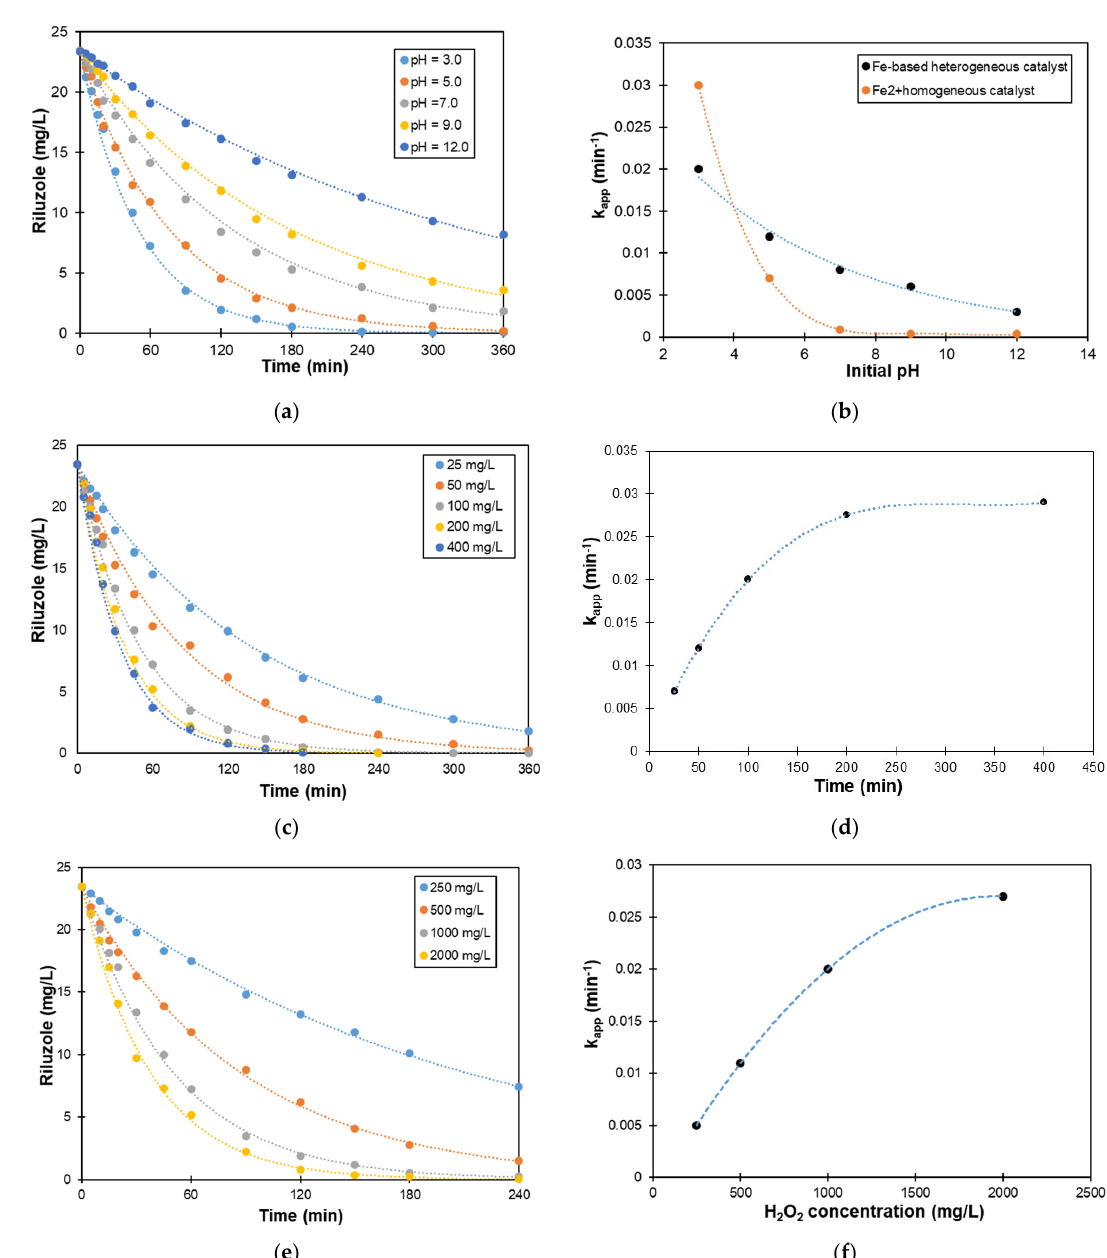
Figure 5. ( a , b ) Effect of initial pH (H 2 O 2 : 1000 mg/L, Fe-based catalyst: 200 mg/L (parti- cle size < 200 µ m), pH: 3.0–12.0), ( c , d ) Effect of catalyst dose (H 2 O 2 : 1000 mg/L, Fe-based cata- lyst: 25–400 mg/L (particle size < 200 µ m), pH = 3.0), and ( e , f ) Effect of H 2 O 2 concentration (H 2 O 2 : 250–2000 mg/L, Fe-based catalyst: 200 mg/L (particle size < 200 µ m), pH = 3.0) on the changes of riluzole concentration with time and on the first-order rate constant during the treatment of 23.4 mg/L riluzole aqueous solutions using a Fe-based catalyst/H 2 O 2 system at T = 23–25 ◦ C and under 400 rpm mixing rate. (Exponential trend lines are added to graphs a, c, and e in dashed